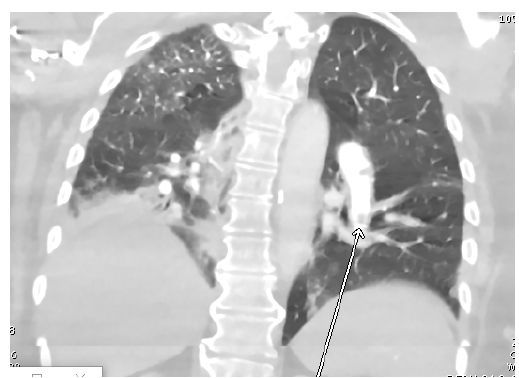
Figure 1. CTA chest showing an embolus in a branch of the left pulmonary artery